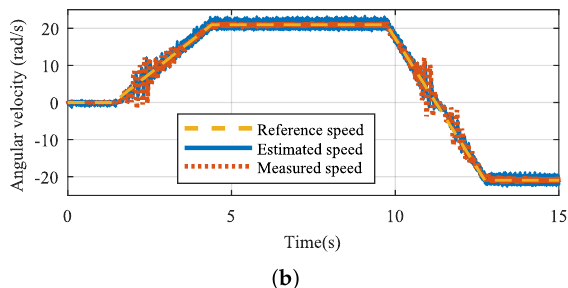
Figure 15. Start-up of the motor only using the estimated position and speed. ( a ) Estimation error. ( b ) Reference (dashed yellow), measured (dotted orange) and estimated (solid blue) speeds.